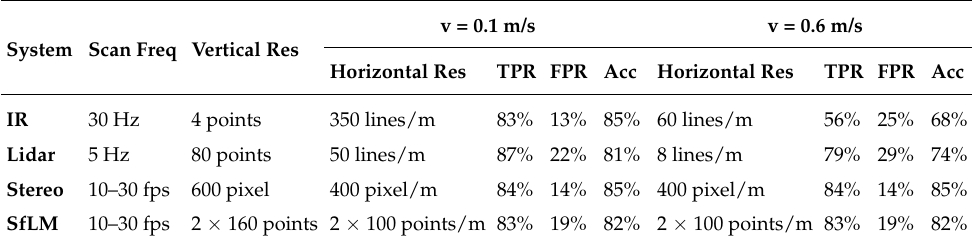
Table 1. Comparison of proposed